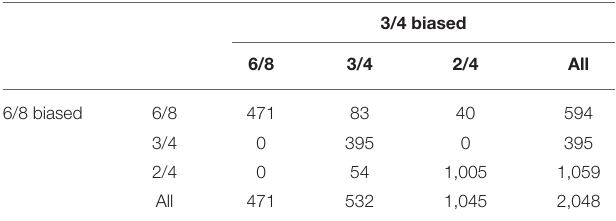
TABLE 3 | A contingency table showing the number of time signature classifications by a 3/4 biased model and a 6/8 biased